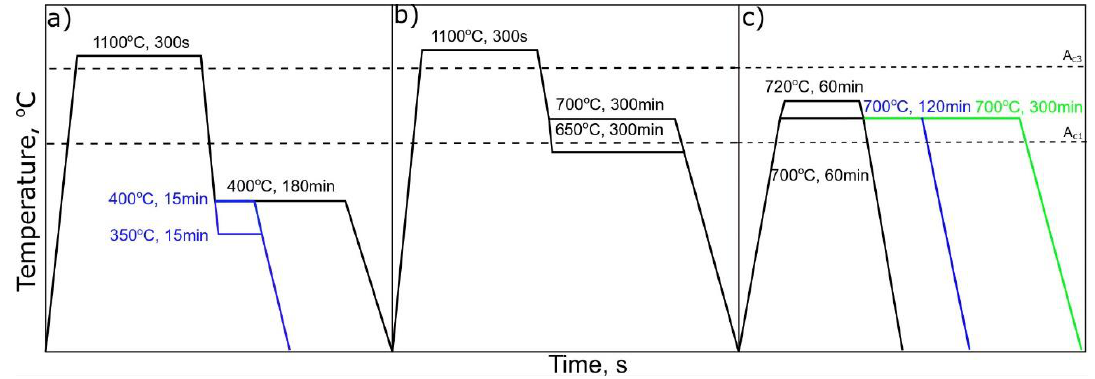
Figure 1. Different heat treatment schedules for analyzed steel: ( a ) in bainite region; ( b ) coiling simulation (ferrite region); ( c ) intercritical annealing.